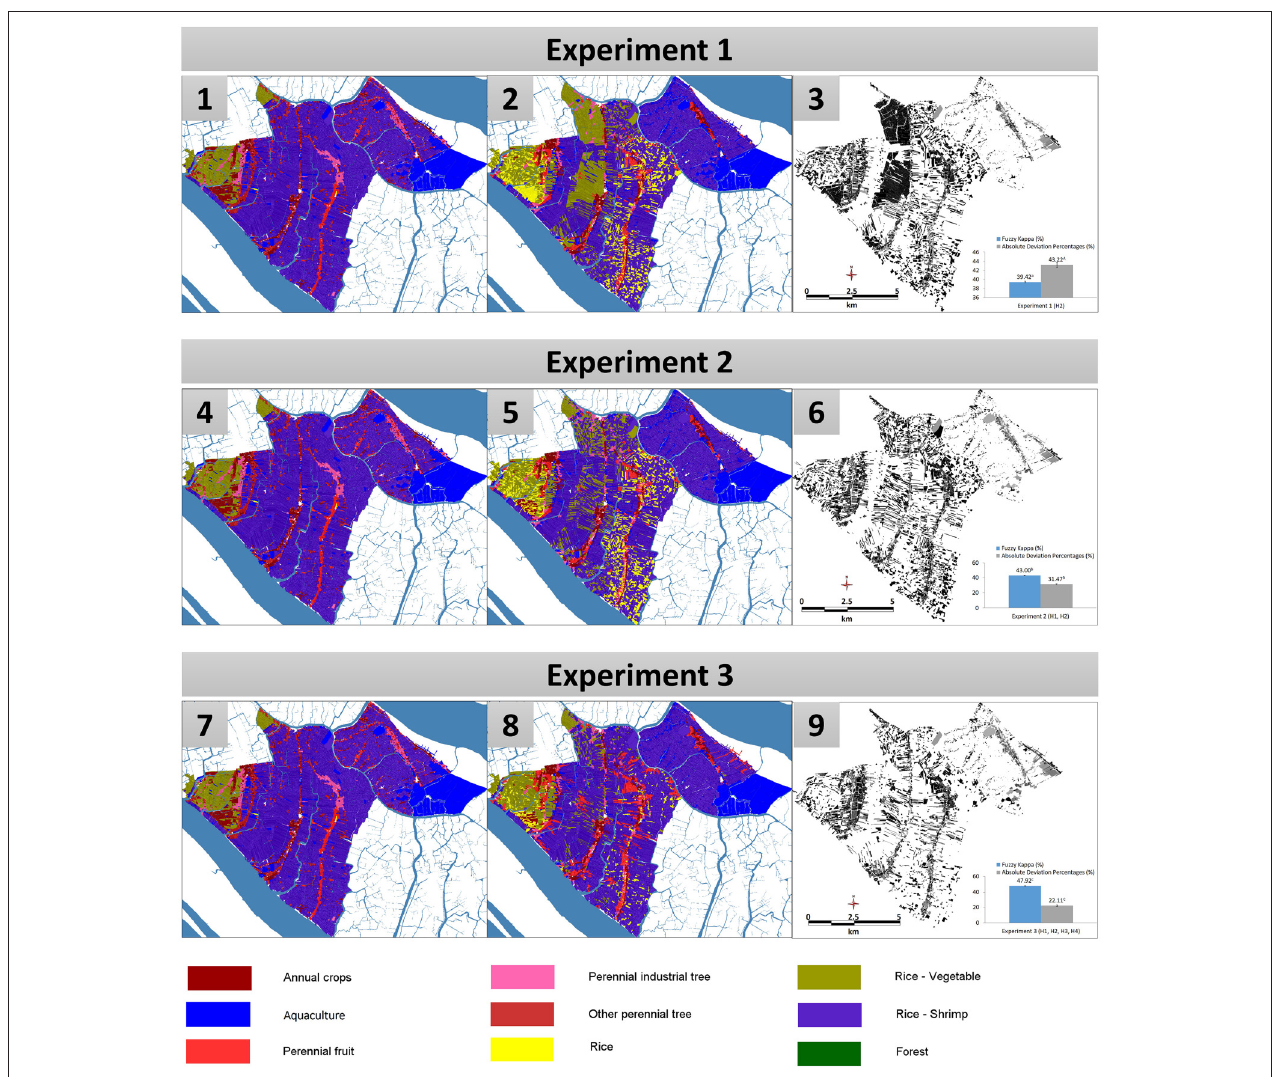
FIGURE 13 | Experiment 1: Comparison between the simulated and observed land-use maps in 2010. Experiment 2: Comparison between the simulated and observed land-use maps in 2010. Experiment 3: Comparison between the simulated and observed land-use maps in 2010. (1), (4), (7) are the results of simulations. (2), (5), (8) are the observed land-use maps in 2010. (3), (6), (9) are the FKappa maps, which show the differences between the two other